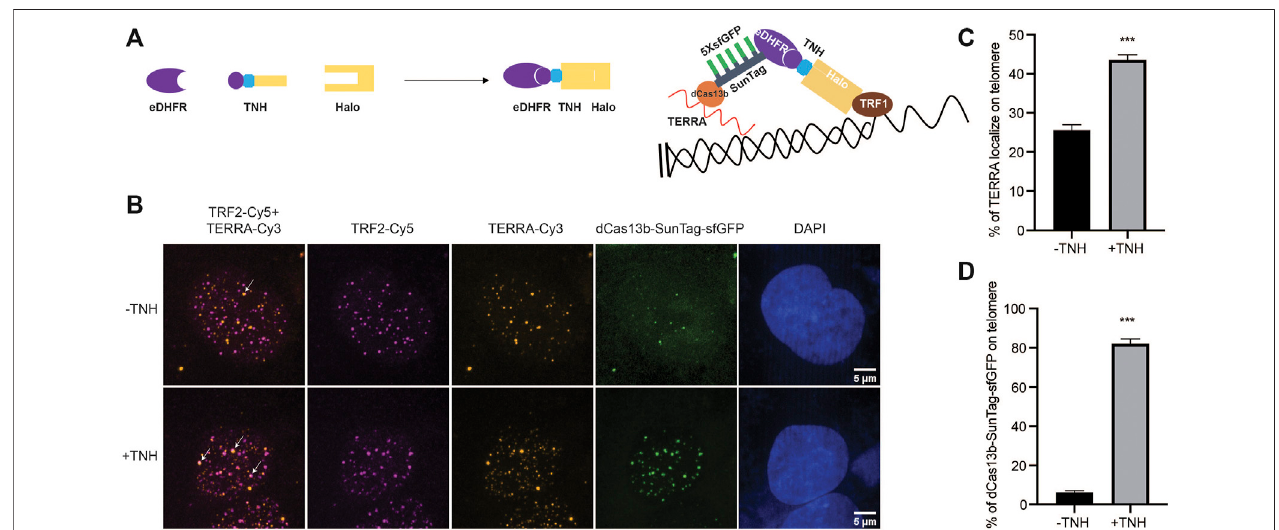
FIGURE4 | Protein dimerization system recruitedTERRA totelomeresthrough Cas13b. (A) Dimerization schematic: SunTag-sfGFP isfused toeDHFR, and TRF1 is fused to Halo-tag. The dimerizer is TNH: TMP-NVOC (6-nitroveratryl oxycarbonyl)-Halo (left panel), with TMP binds eDHFR, and Halo-ligand binds to Halo-tag. Schematic diagram of TERRA recruitment on telomere via dimerization system (right panel). (B) Representative images of TERRA localization on telomere veri fi ed by TERRA FISH. Arrow indicates colocalization of TERRA-Cy3 and TRF2-Cy5. (C) Quanti fi cation of the percentage of TERRA localized on telomere (mean ± SEM, unpaired t -test). N ≥ 60 for each group. *** p < 0.001. N.S., not signi fi cant. (D) Quanti fi cation of the percentage of dCas13b-SunTag-sfGFP localized on telomere indicated by TRF2-Cy5 (mean ± SEM, unpaired t -test). N ≥ 30 for each group. *** p <